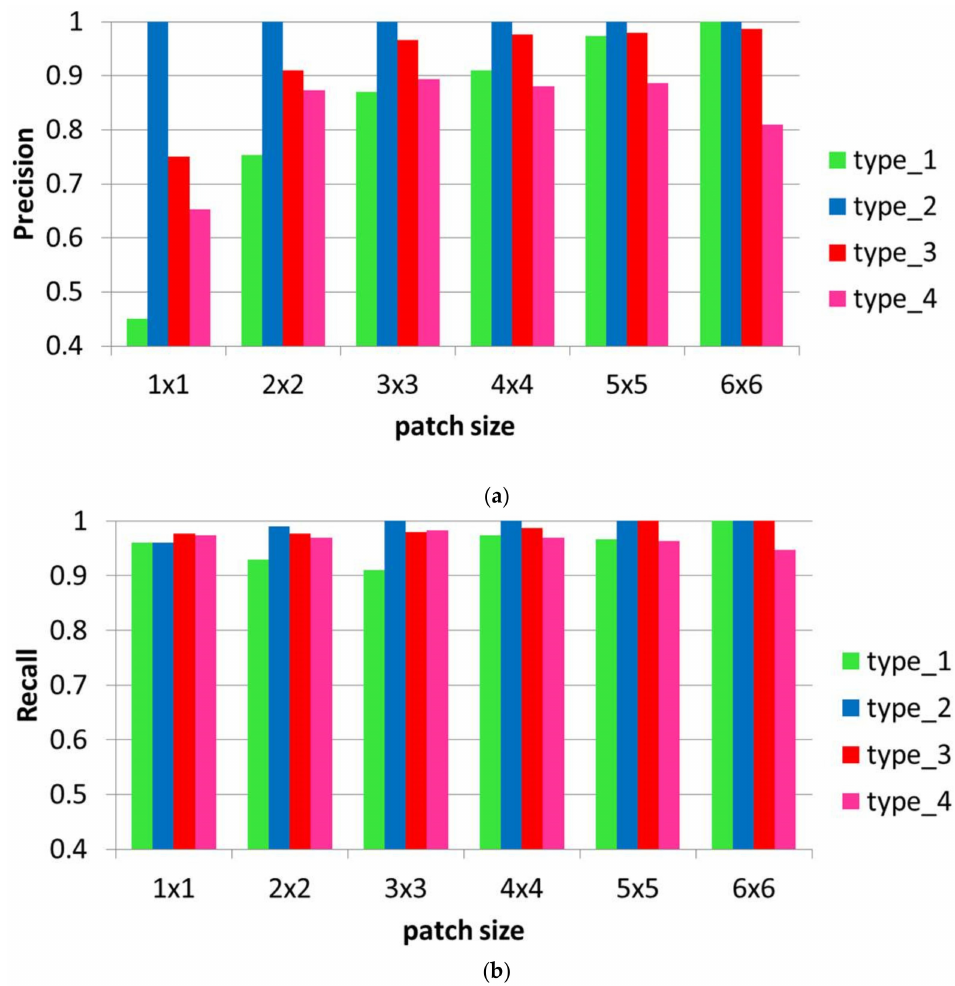
Figure 10. Bar graph of accuracy estimators for the different classes vs. the input patch size. ( a ) Precision; ( b )